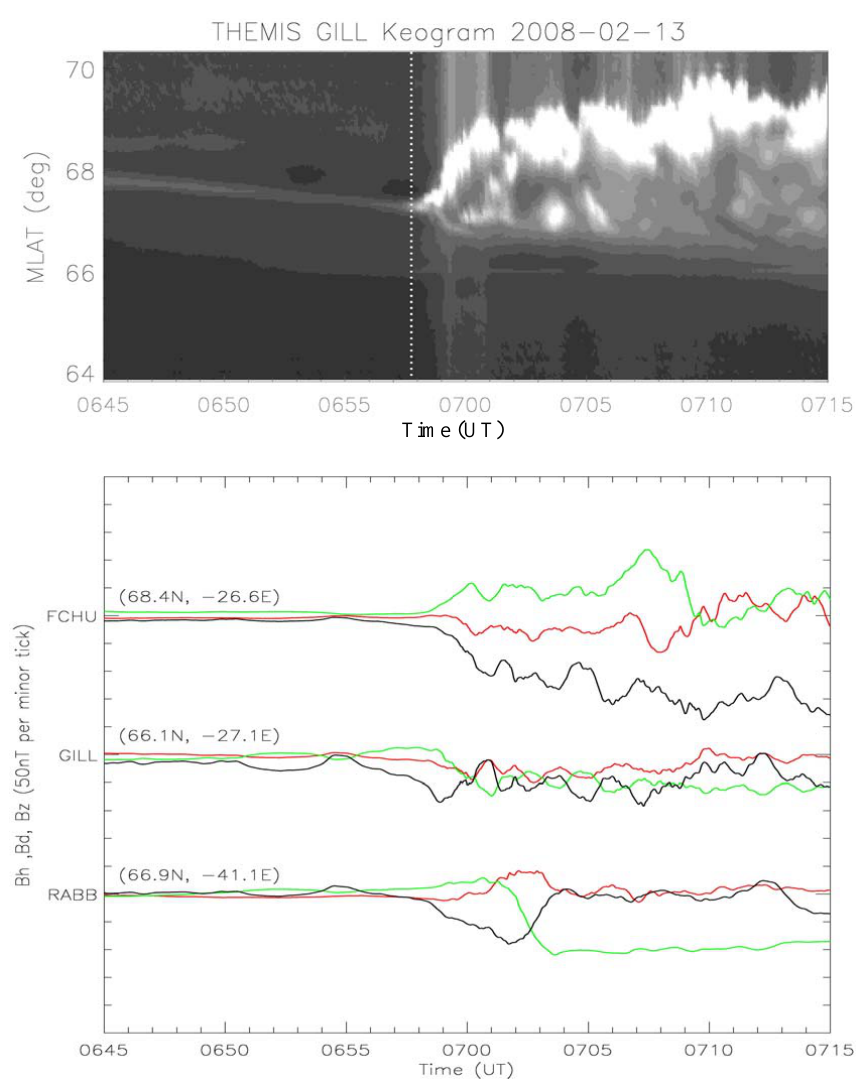
Fig. 4. The first panel show the keogram of THEMIS GILL ASI; The rest panels shows the magnetograms from FCHU, GILL and RABB stations. Black, green and red lines denote the H, D, and Z components of the ground magnetic